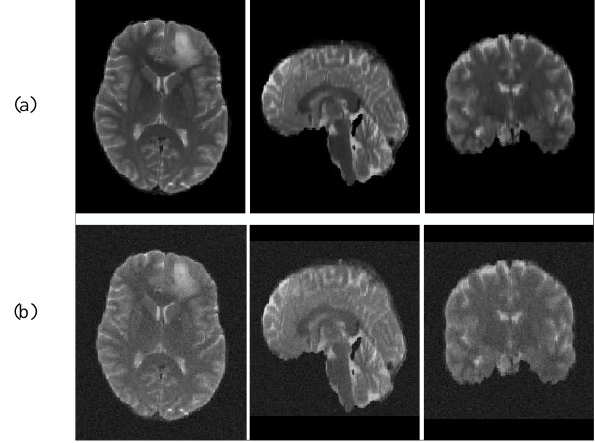
Figure 5. T2 images add noise contrast. ( a ): with no noise, ( b ): with noise.